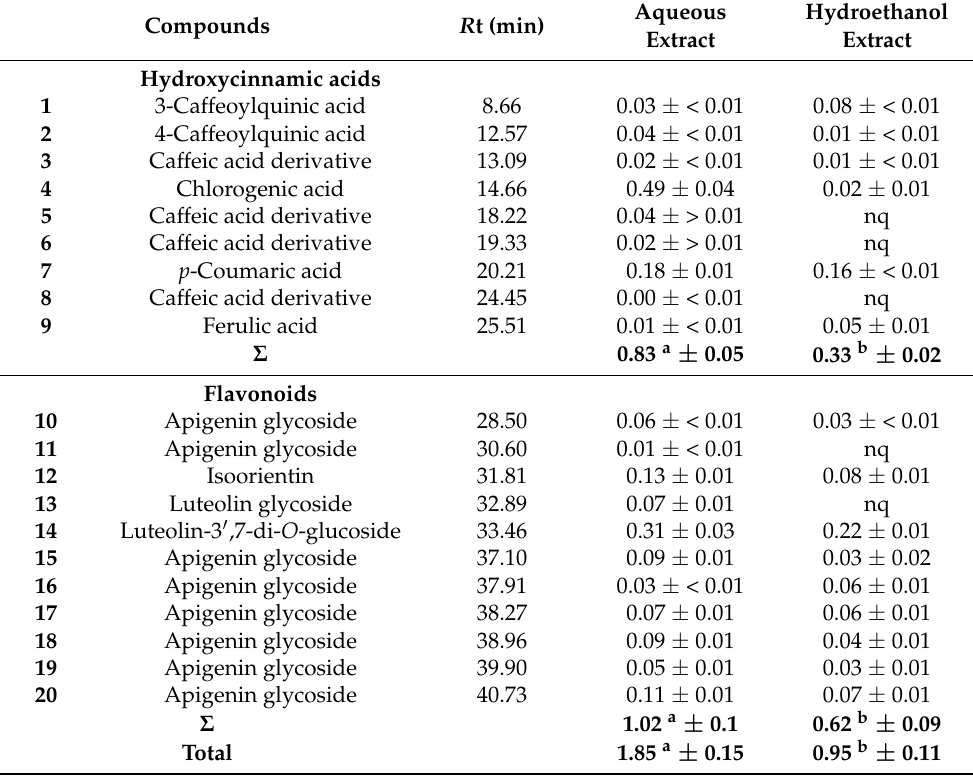
Table 1. Quantification of the phenolic compounds identified in camel grass extracts 1 . Compounds R t (min)